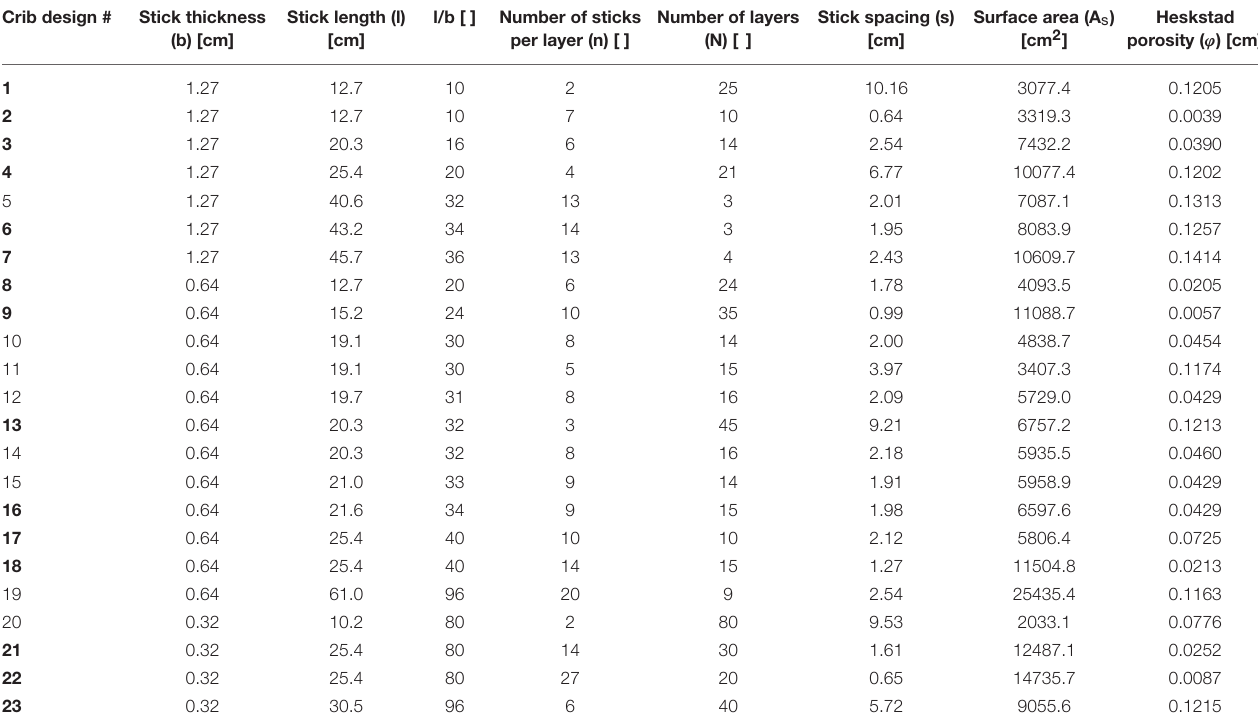
TABLE 1 | Crib designs